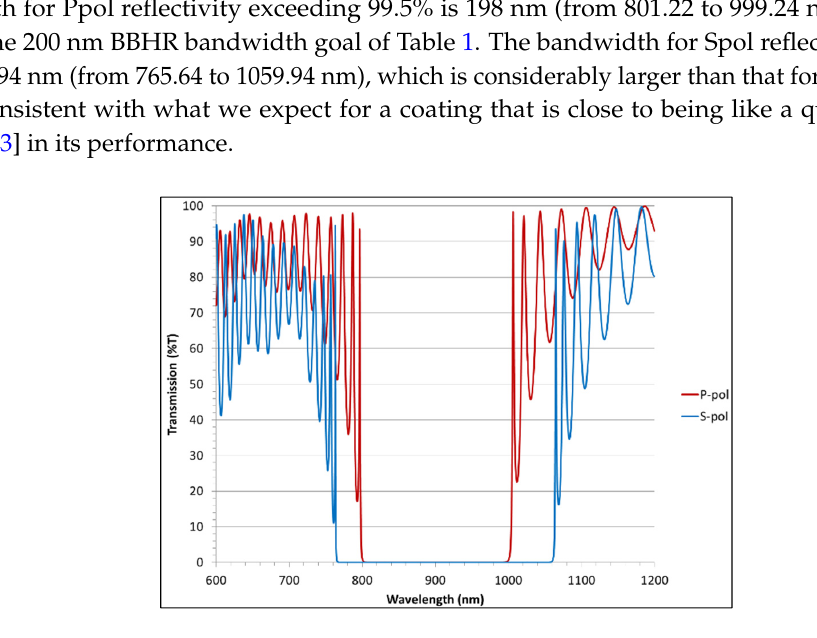
Figure 3. Ppol and Spol transmission spectra at 45° AOI for the BBHR coating design.